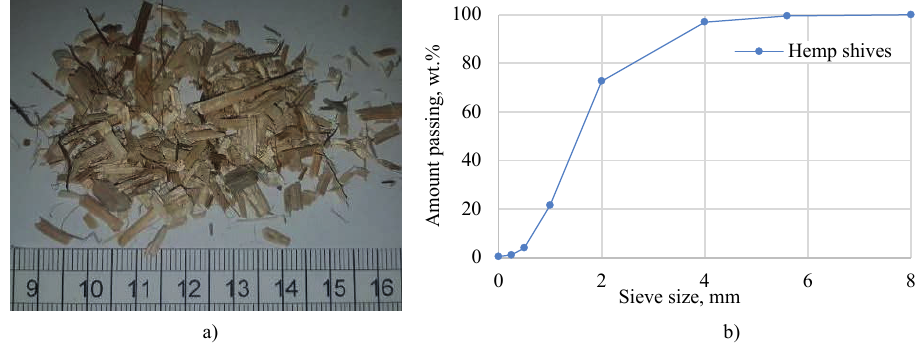
Fig. 1. Hemp shive macrostructure (a) and particle size distribution